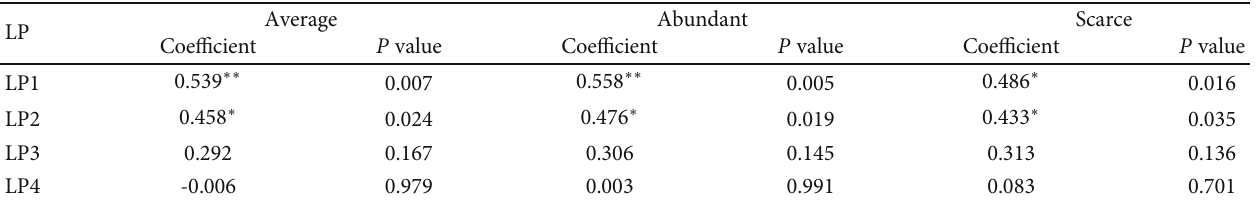
Table 4: Results of 2-tailed tests showing the solar load correlation coe ffi cients and P values of various load pro fi les (LPs) under average, abundant, and scarce solar resource conditions.